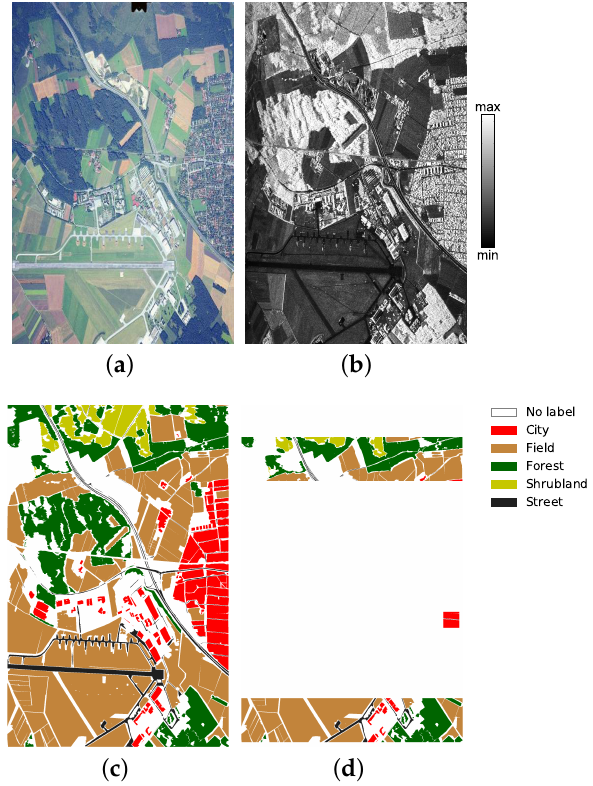
Figure 4. Visualization of optical image of the area, SAR intensity image, manually labelled reference data and subset used to train the RF classifier. ( a ) Optical image; ( b ) SAR Intensity; ( c ) Reference labels; ( d ) Training